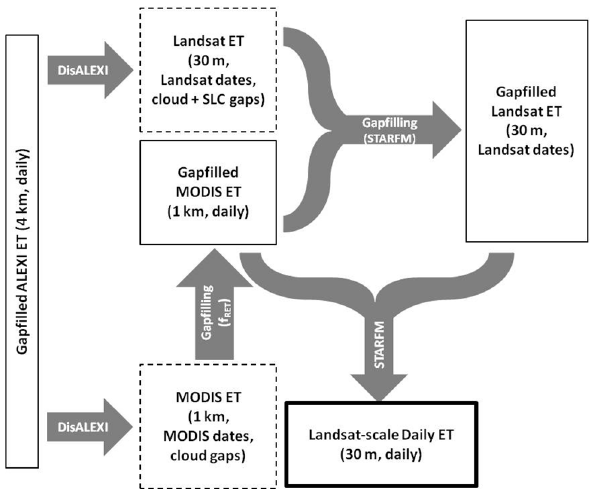
Figure 2. Flowchart describing the Landsat gap-filling and data fu- sion method. The arrows represent the methods applied. The boxes represent the datasets with different spatial and temporal charac- teristics created during the process. The dashed boxes indicate ET products with partially filled scenes (due to clouds or SLC gaps); solid boxes identify gap-filled scenes and the thick box highlights the final gap-filled 30m daily